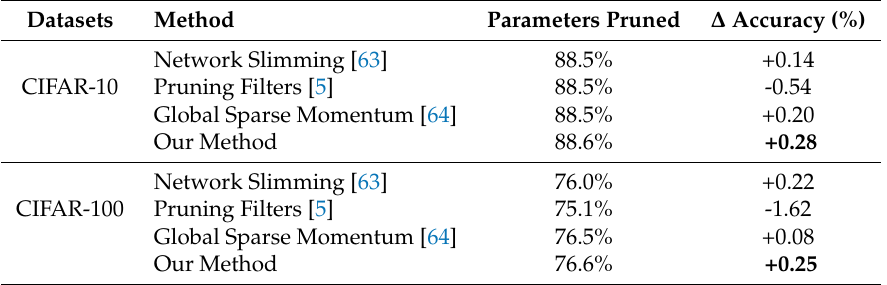
Table 6. Comparison between NAC and two related approaches on the CIFAR-10 and CIFAR-100